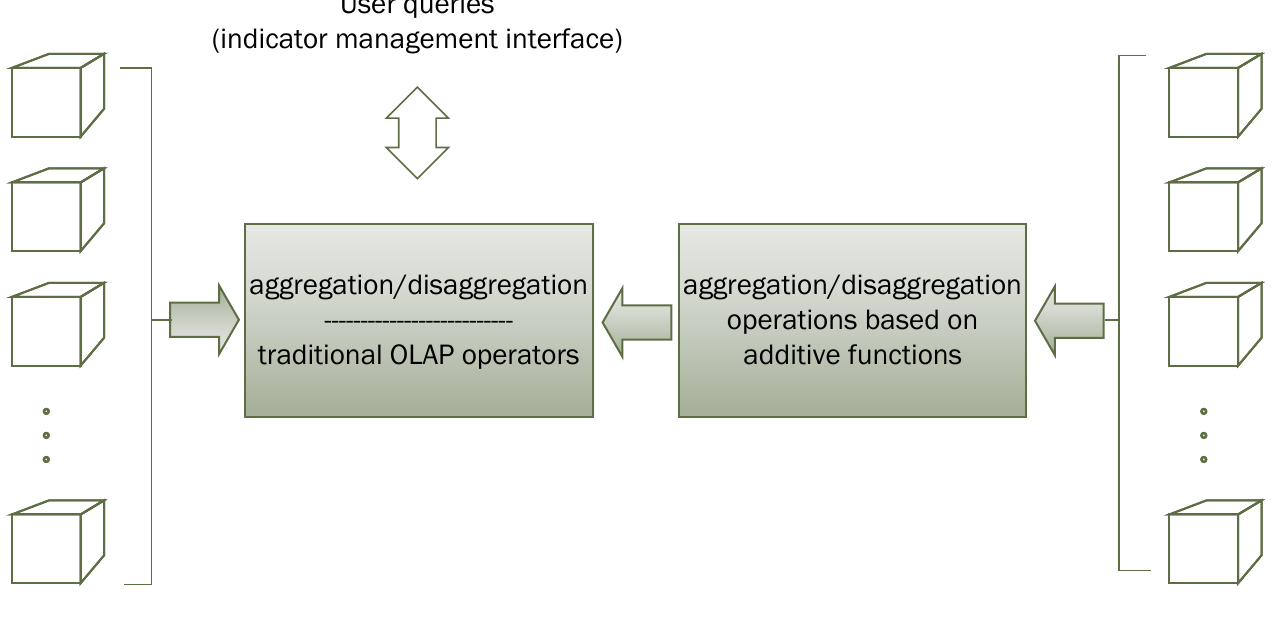
Figure 8. Multidimensional subsystem (On-Line Analytical Processing